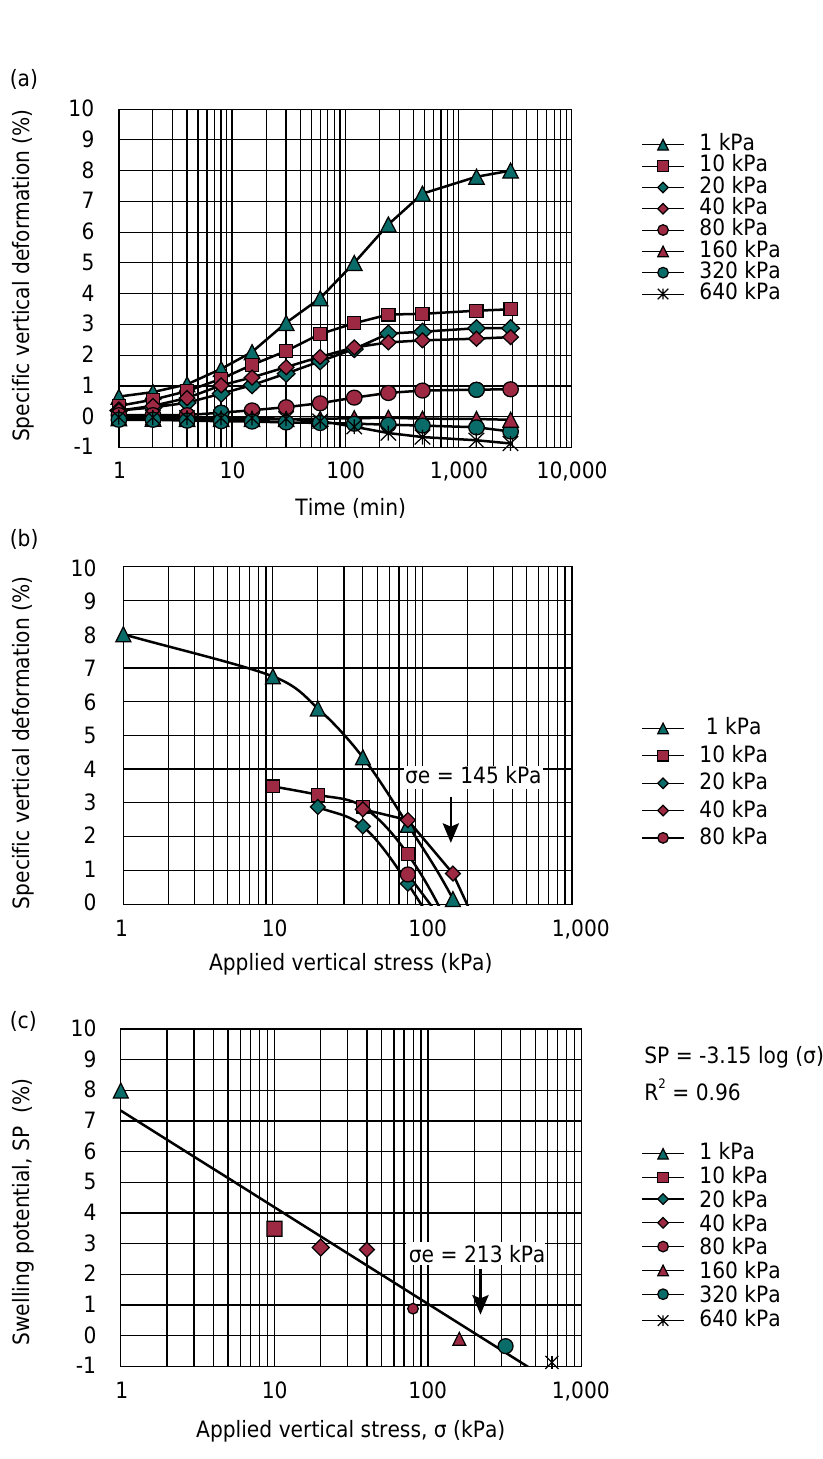
Figure 2. Swelling stress (σe): (a) expansion under stress; (b) Method 1: loading after expansion with different vertical consolidation stresses; (c) Method 2: swelling and